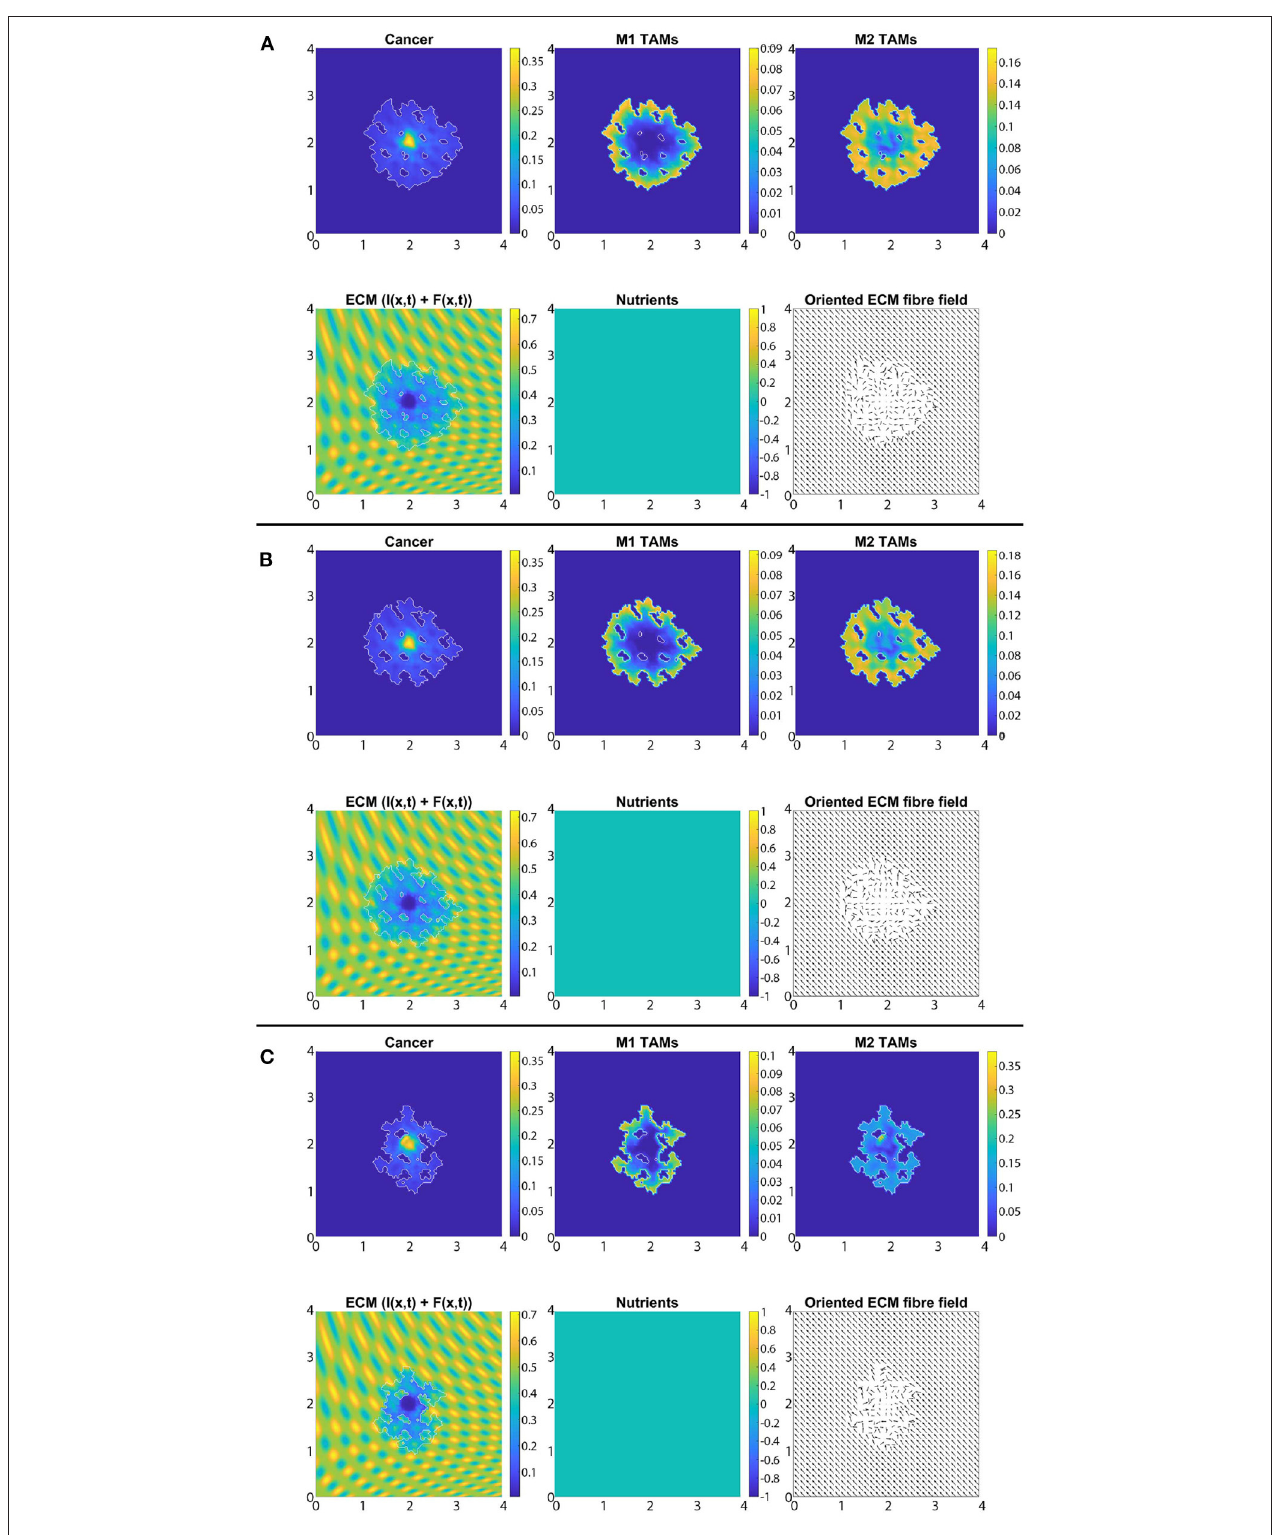
FIGURE 11 | Baseline simulation with no macrophage re-polarisation and no nutrients (i.e., σ ( x , t ) ≡ 0, ∀ ( x , t ) ∈ Y × [0, T ] and 9 p ( σ ) ≡ 1, 9 dc ( σ ) ≡ 1, 9 dM ( σ ) ≡ 1 and 9 M ( σ ) ≡ 1, ∀ σ and S M σ = 0) at final time 50 1 t . (A) β = 0.75, (B) β = 0.7875, and (C) β =